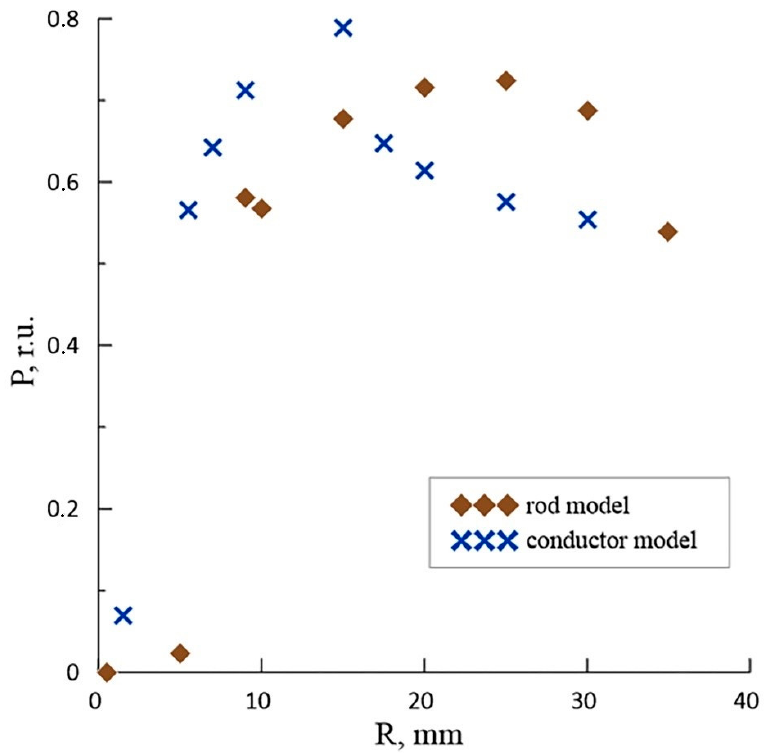
Figure 5. Probability of transition of a pulse streamer corona flash into an upward leader as a function of the tip radius of the rod electrode (radius of the tubular electrode).